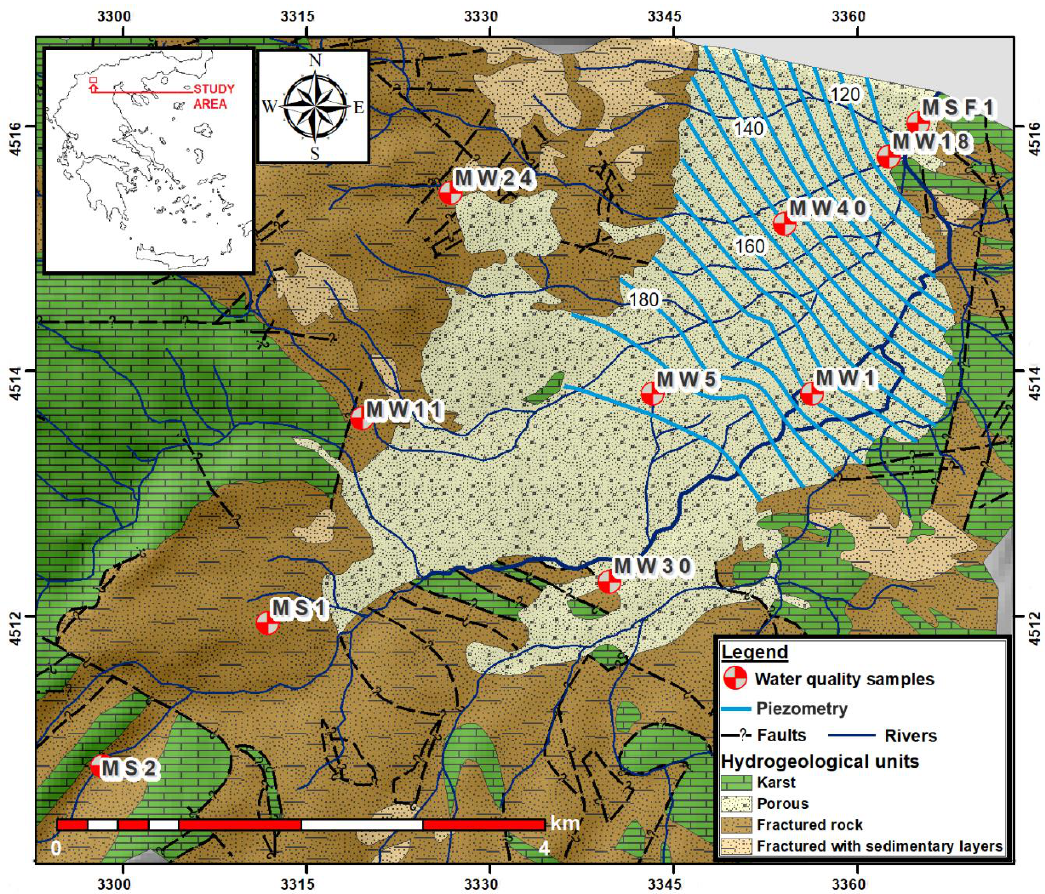
Figure 1. Hydrogeological map of the study area. For samples, W indicate wells and S identify the springs.